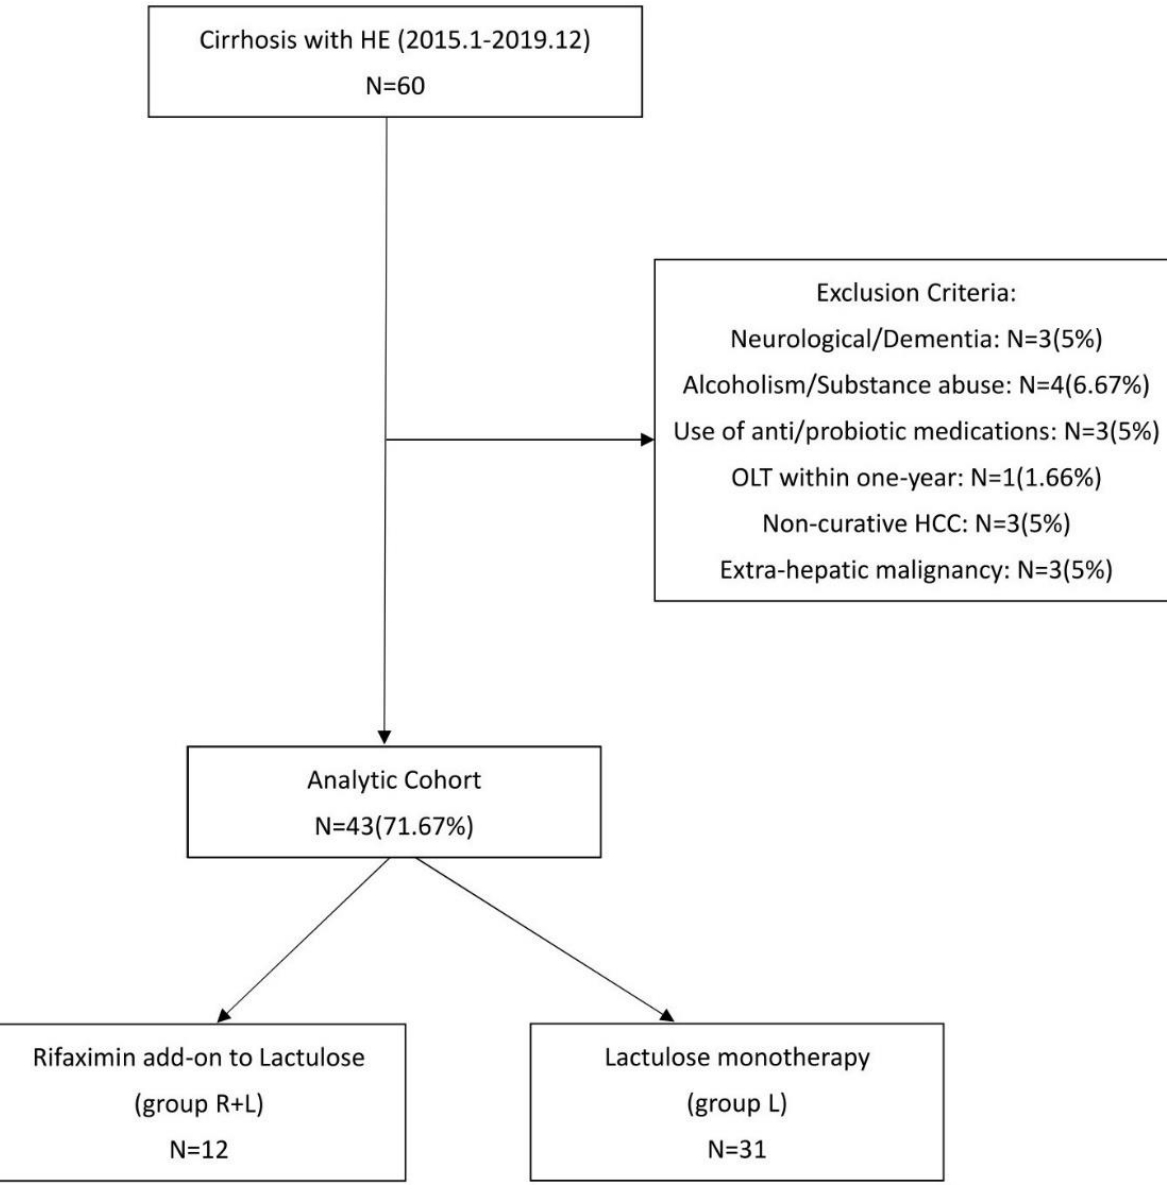
Figure 1. Flow chart of the study.